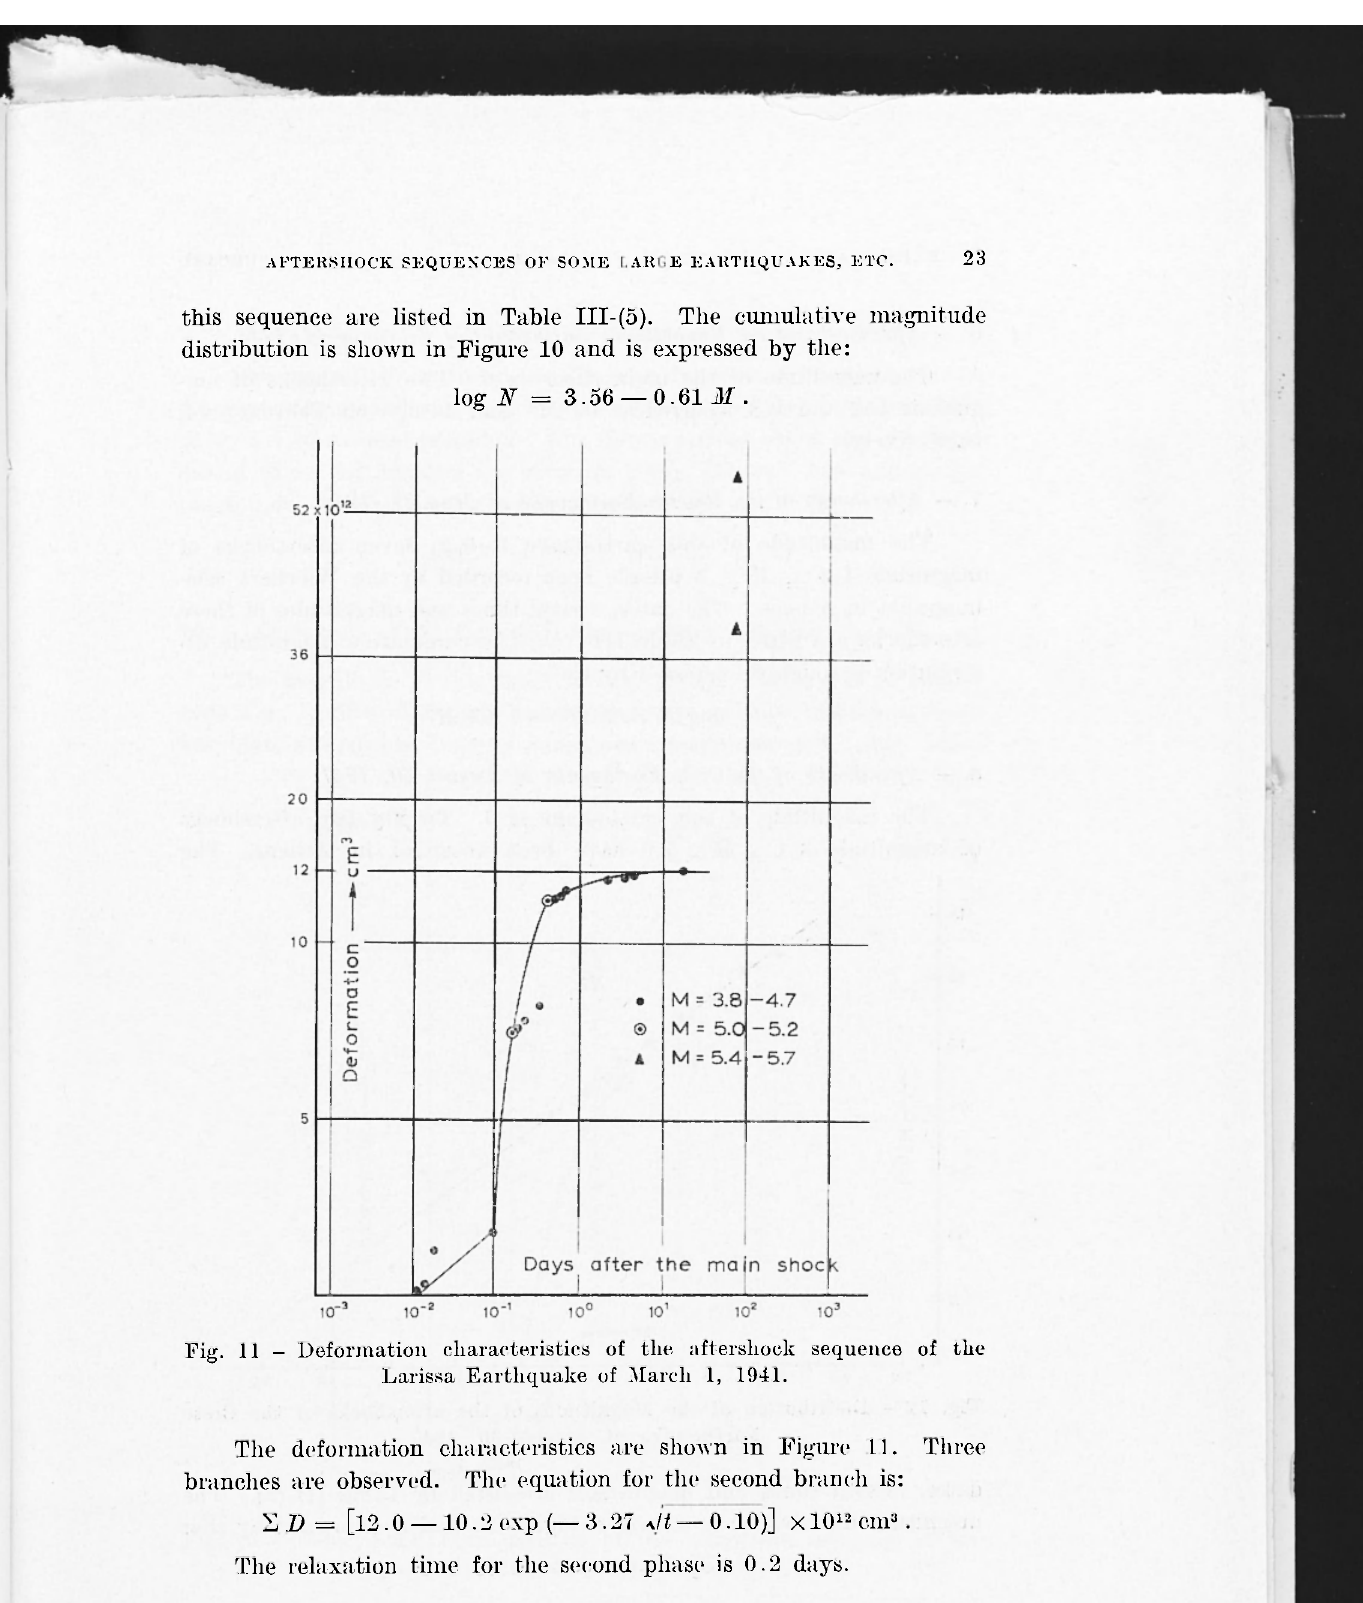
Fig. 11 — Deformation characteristics of the aftershock sequence of the Larissa Earthquake of March 1,